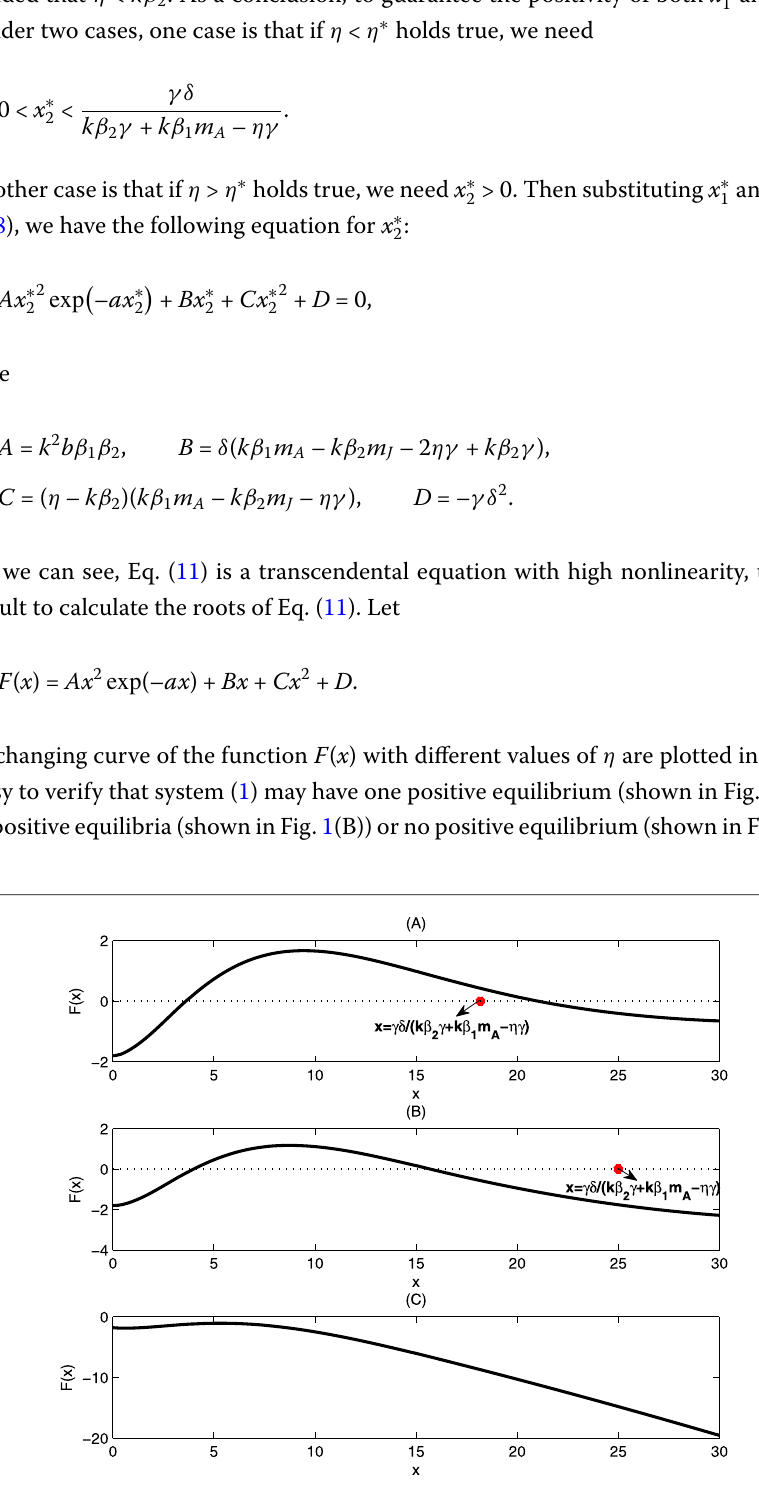
Figure 1 The curve of the function F ( x ) with η = 0.01 in ( A ), η = 0.04 in ( B ) and η = 0.18 in ( C ). The other parameter values are b = 50, δ = 2, a = 0.22, β 1 = 0.2, β 2 = 0.1, k = 0.4, γ = 0.45, m A = 0.45, m J = 0.8. Note that here η ∗ =